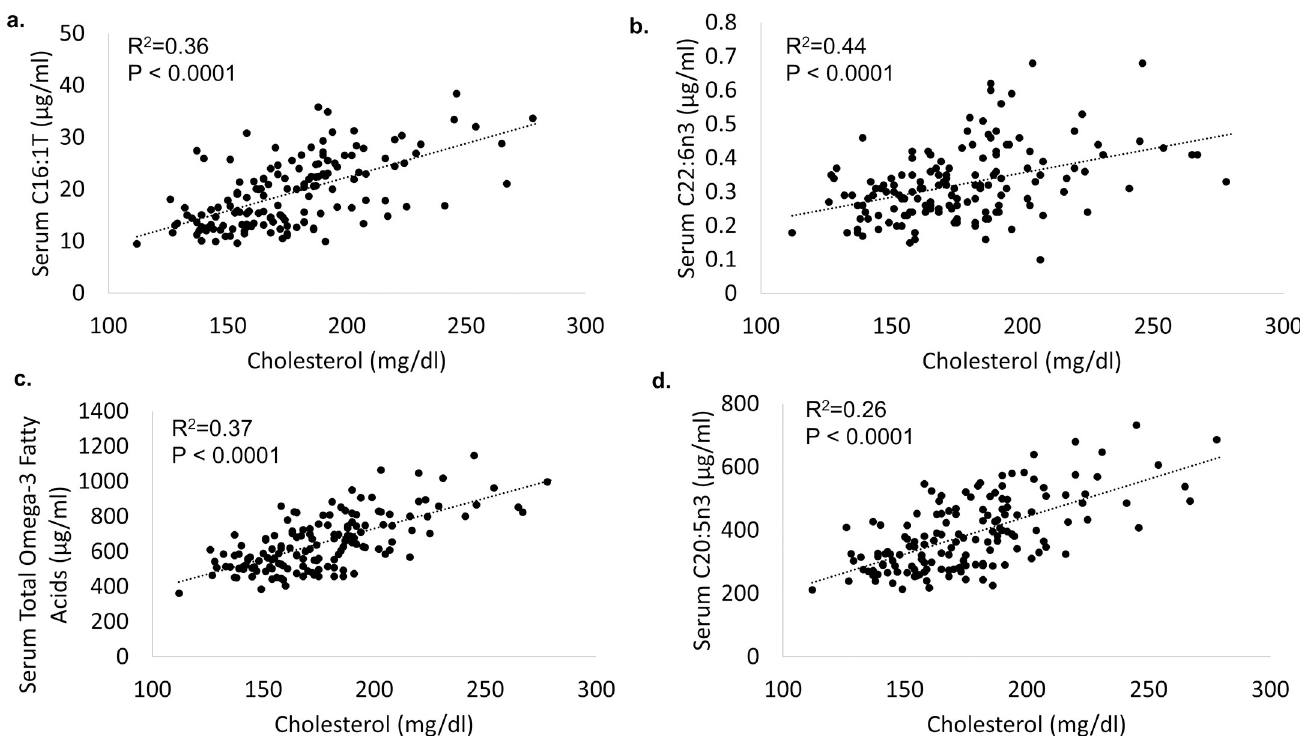
Fig 4. Independent and linear serum fatty acid predictors of cholesterol in bottlenose dolphins, including (a) C16:1T, (b) C22:6n3 (DHA), (c) total omega-3 fatty acids, and (d) C20:5n3 (EPA).